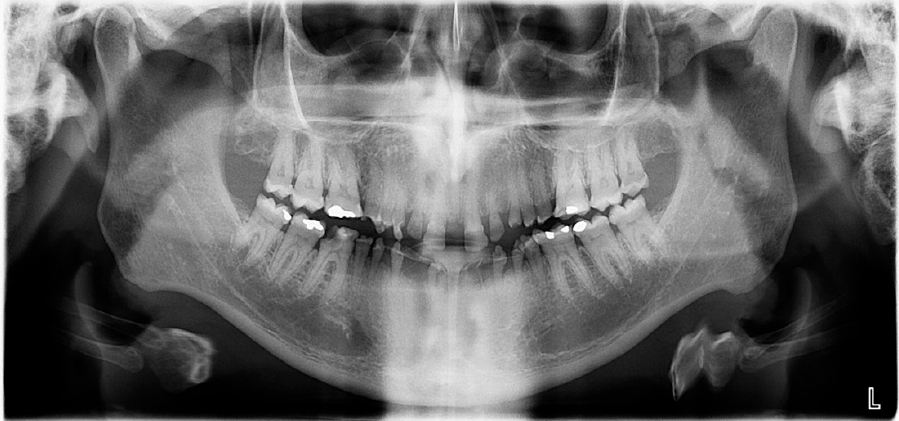
Figure 4. Panoramic radiograph before treatment.